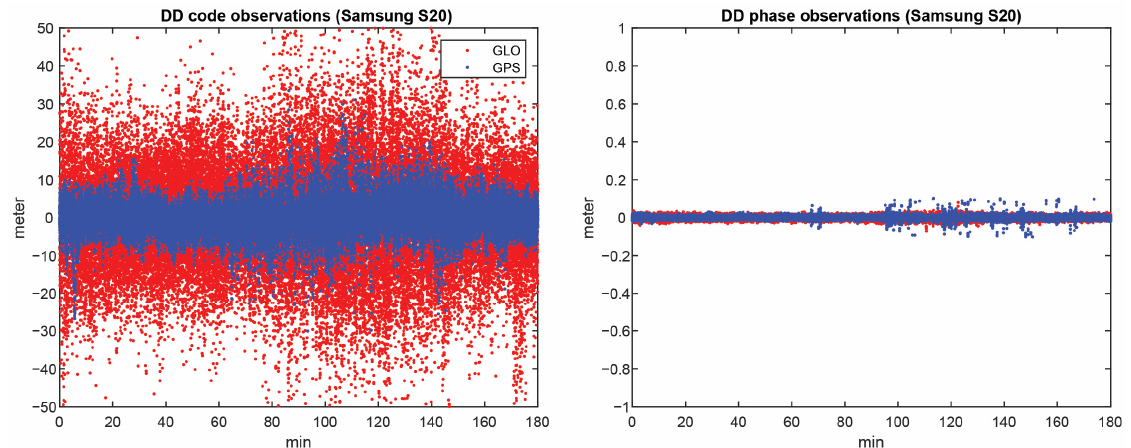
Figure 6. DD observations of GPS and GLONASS for all visible satellites: ( left ) code and ( right ) phase observations. Table 4. Mean and RMS of the DD code and phase observations on L1 frequency (in meters).